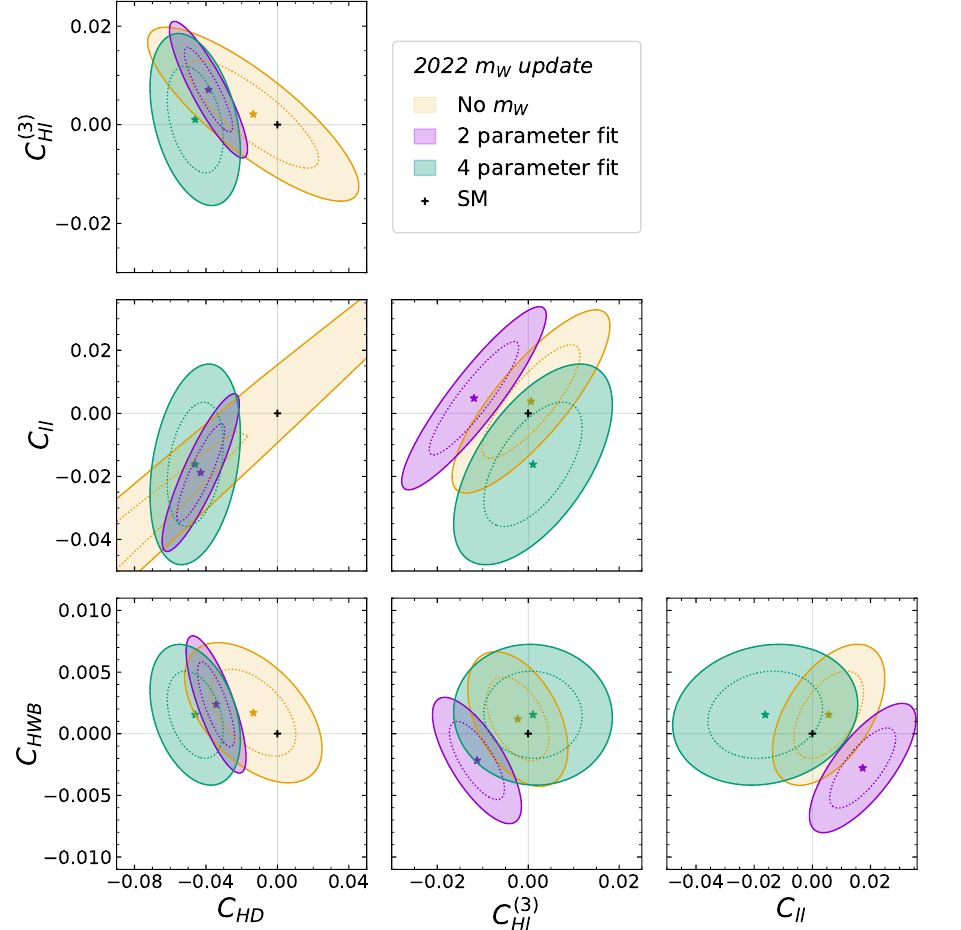
Figure 5 . Planes of pairs of the coefficients of operators that can affect m W , comparing the constraints obtained when omitting m W measurements from the fit (beige), marginalising over just the four operators that affect m W (green), and marginalising over only the two operators in each plane